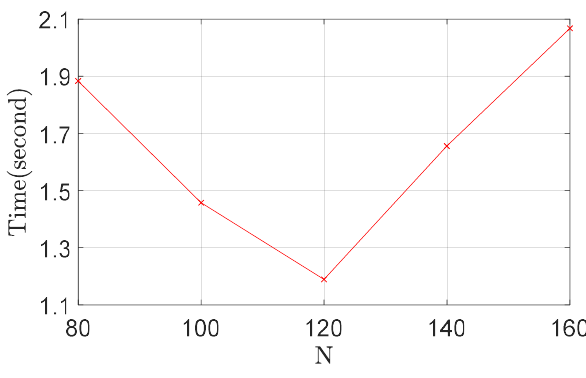
Figure 7. The e ff ect of N on the detection efficiency.